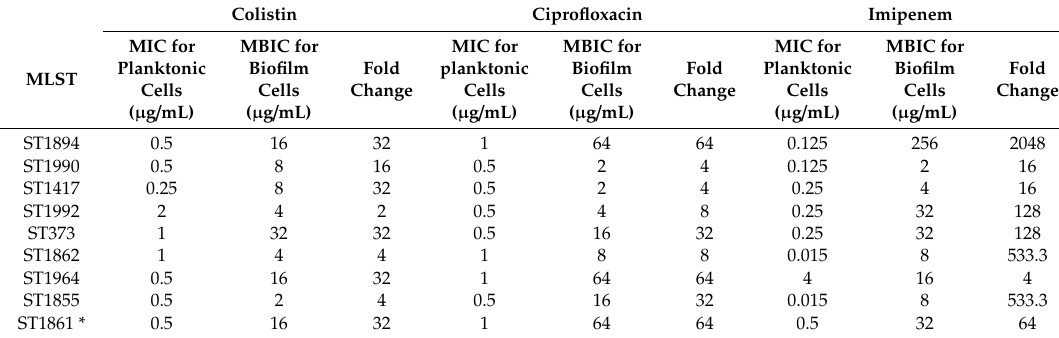
Table 5. Antibiotic susceptibility profiles of selected sequence types of A. baumannii planktonic and biofilm cells.